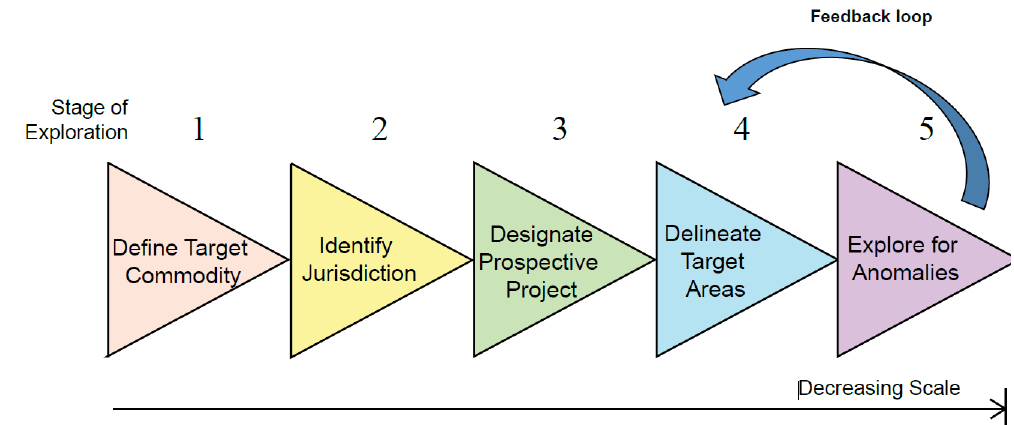
Figure 2. The stages of exploration targeting. Within each stage there is a period of data collection, integration, and analysis. Moving between stages requires a reduction in real options, such that a decision is made to focus on a specific area, decreasing the overall exploration search space. Although a single feedback loop is presented, it is noted that the true process of exploration is far less rigid. Feedback occurs at all stages, potentially leading to a reverse step in the process. For example, newly acquired data may present a case for defining a different, or second, target commodity within a project area.